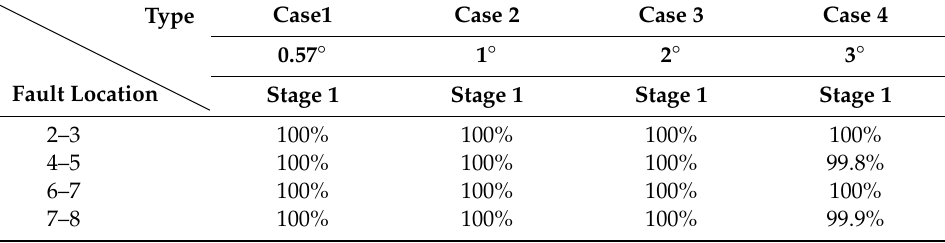
Table 7. Accuracy of the fault location according to phasor angle error (fault in the main feeder).